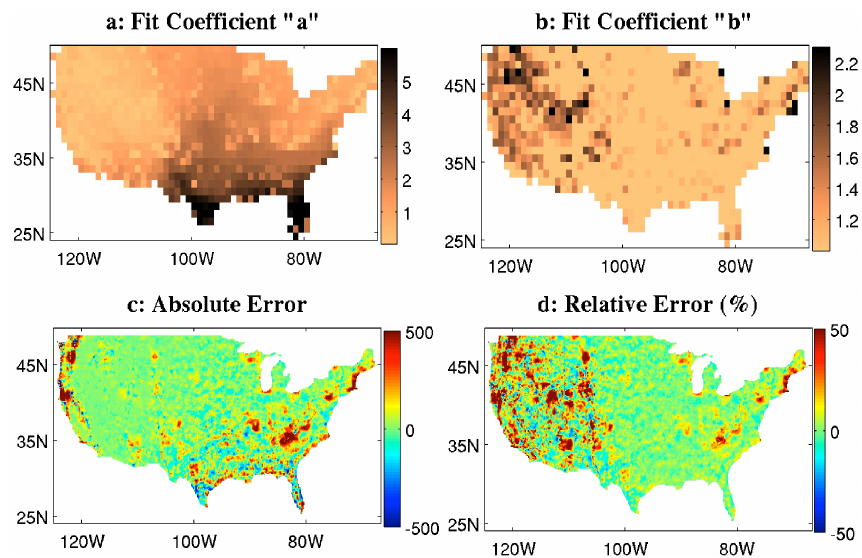
Figure 4. Evaluation of observational estimates of R . Method 1: erosivity calculated from daily precipitation, using the formula R = P N P 365 a P b (details in the text). (a) The multiplicative coefficient “ a ” in the above formula, calculated by regression on the grid points n d d N in each 1 ◦ × 1 ◦ box (b) , as in (a) , but for the exponent coefficient “ b ”. (c) Absolute error between the estimate of R in Fig. 3b and the target field in Fig. 3a. (d) Relative error in